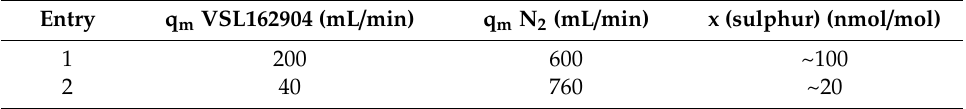
Table 4. Dilutions according to ISO 6145-7